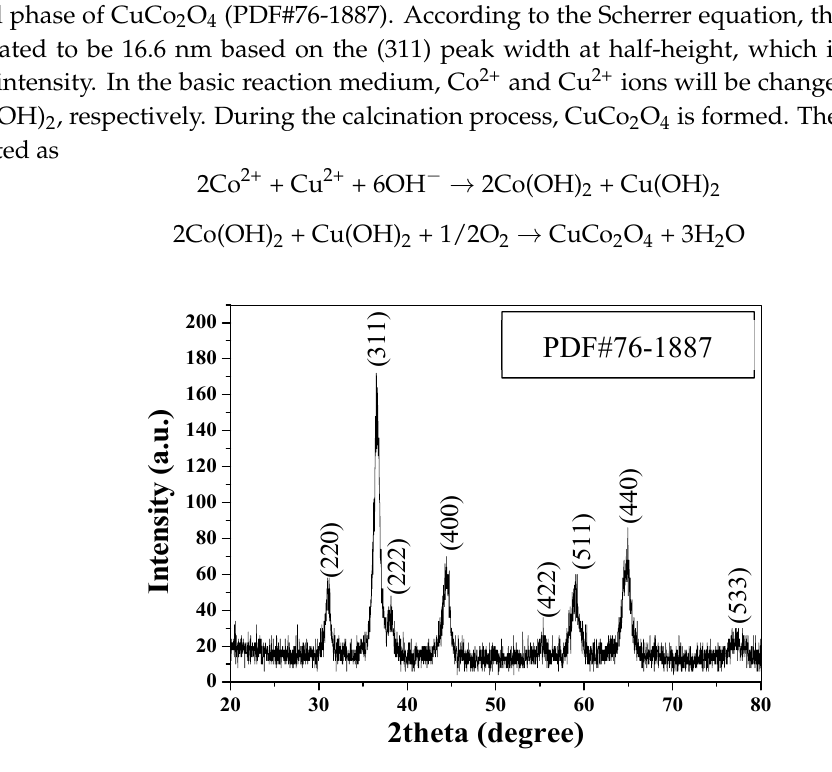
Figure 1. XRD pattern of the CuCo 2 O 4 nanoplatelets.